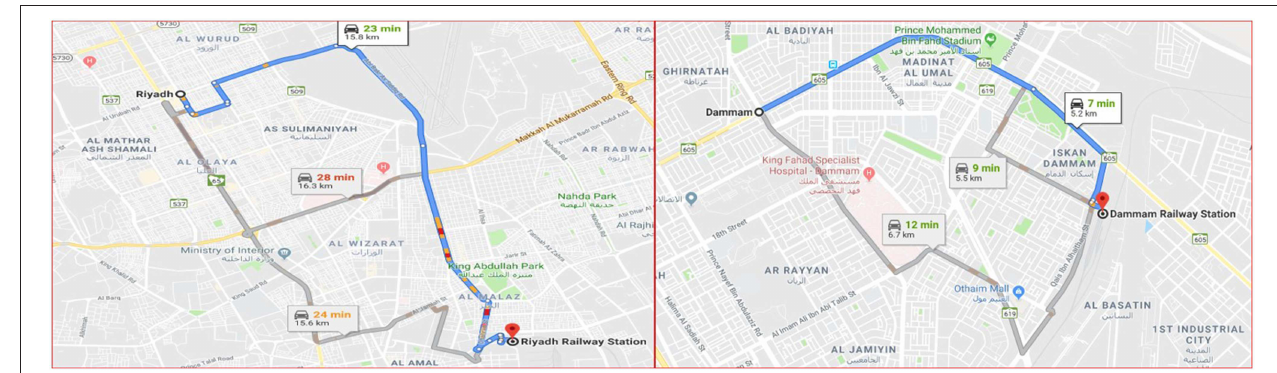
FIGURE 2 | Driving to/from Riyadh Railway Station ( Left ) and to/from Dammam Railway Station ( Right ). Source: Google Map.